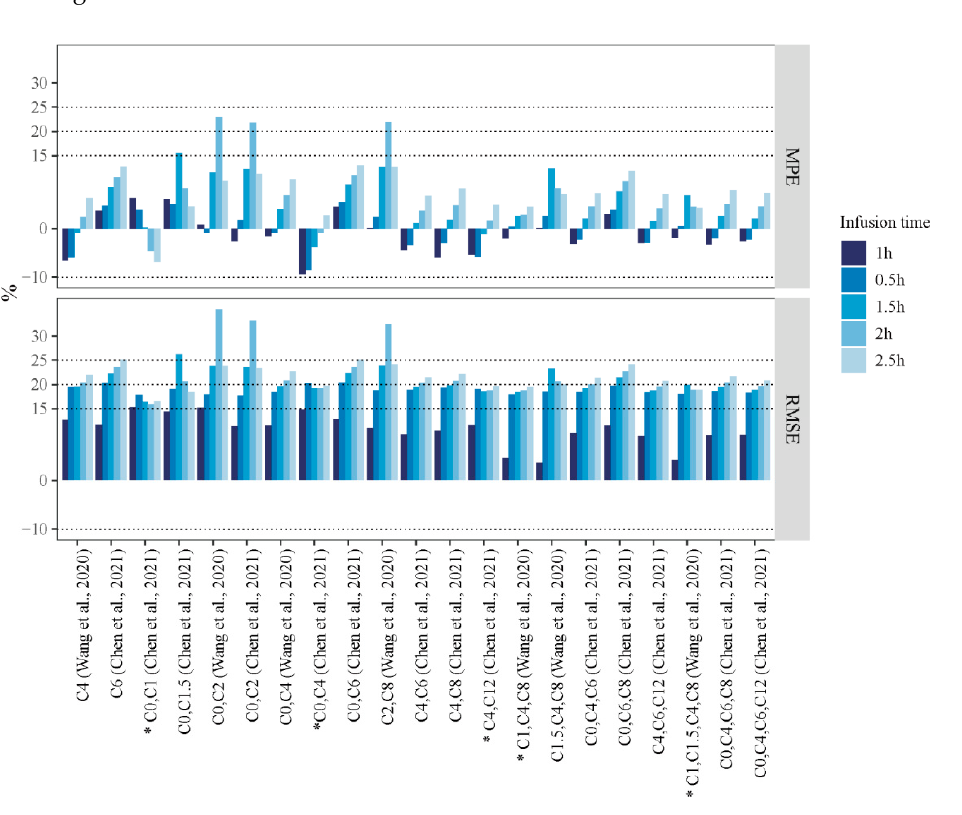
Figure 4. The MPE and the RMSE of the AUC pred under the selected LSSs following the different infusion times (Chen et al., 2021[21] and Wang et al., 2020 [22]). * Model with the most stable predictive performance.